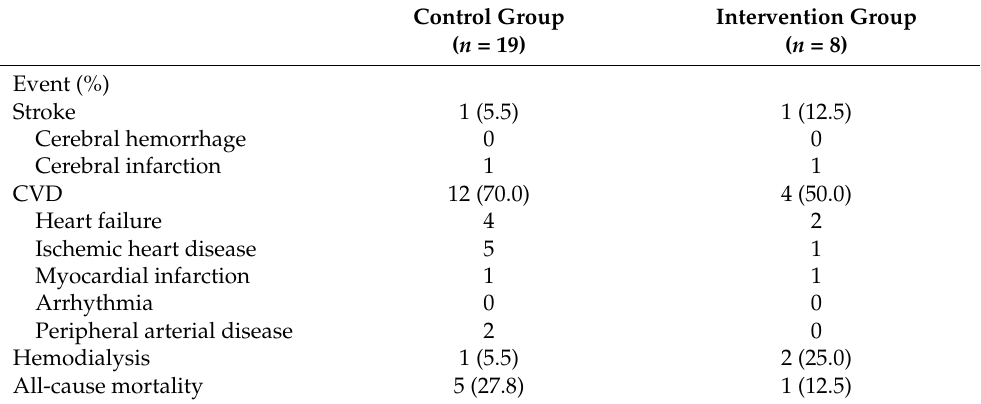
Table 4. Clinical characteristics between the two groups at the start and end of the observation.